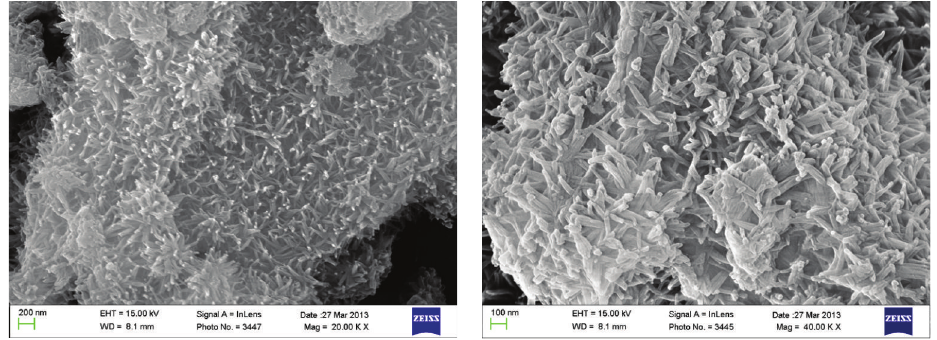
Figure 3: SEM images of the title complex with different amplifying